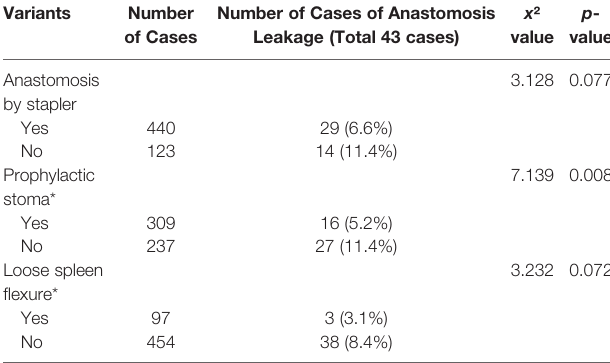
TABLE 3 | Univariate analysis of postoperative anastomotic leakage of 563 cases after LA-taTME.